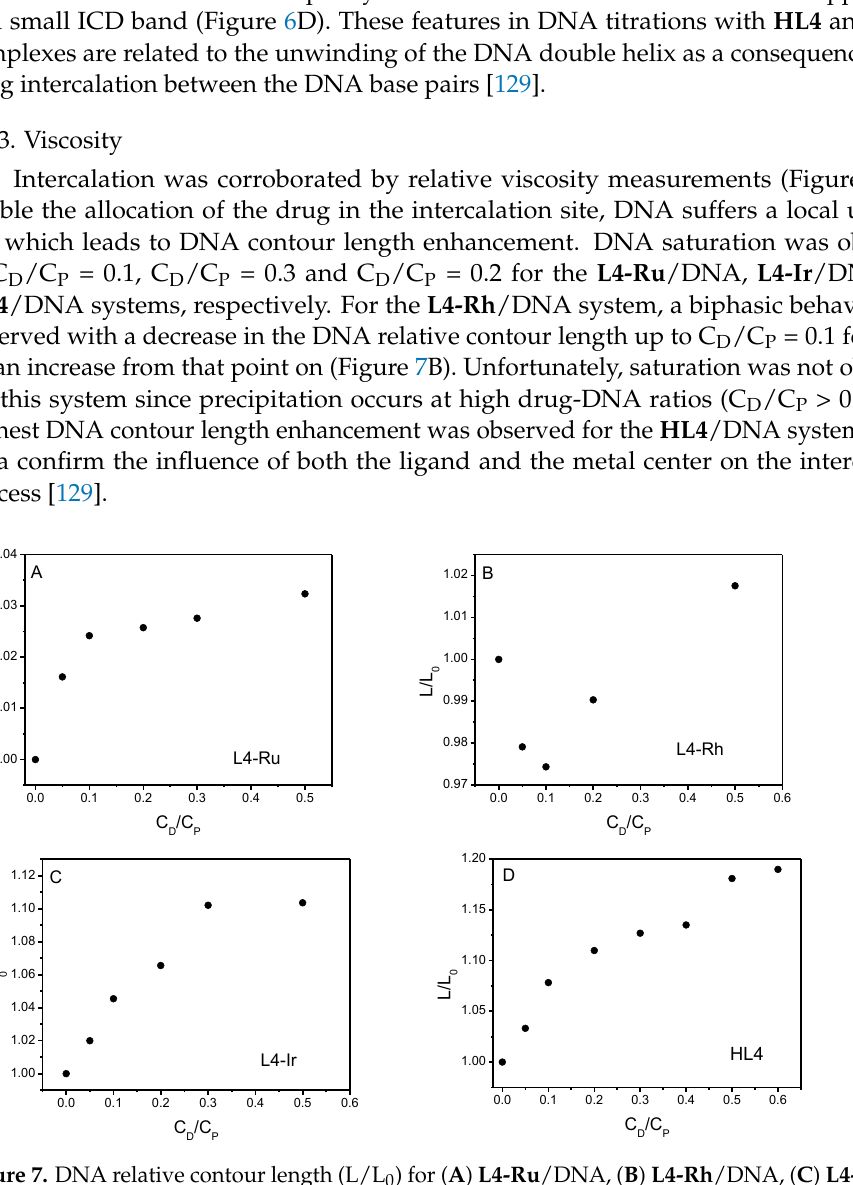
Figure 7. DNA relative contour length (L/L 0 ) for ( A ) L4-Ru /DNA, ( B ) L4-Rh /DNA, ( C ) L4-Ir /DNA and ( D ) HL4 /DNA systems as a function of the C D /C P ratio. C P0 = 2.0 × 10 −4 M.